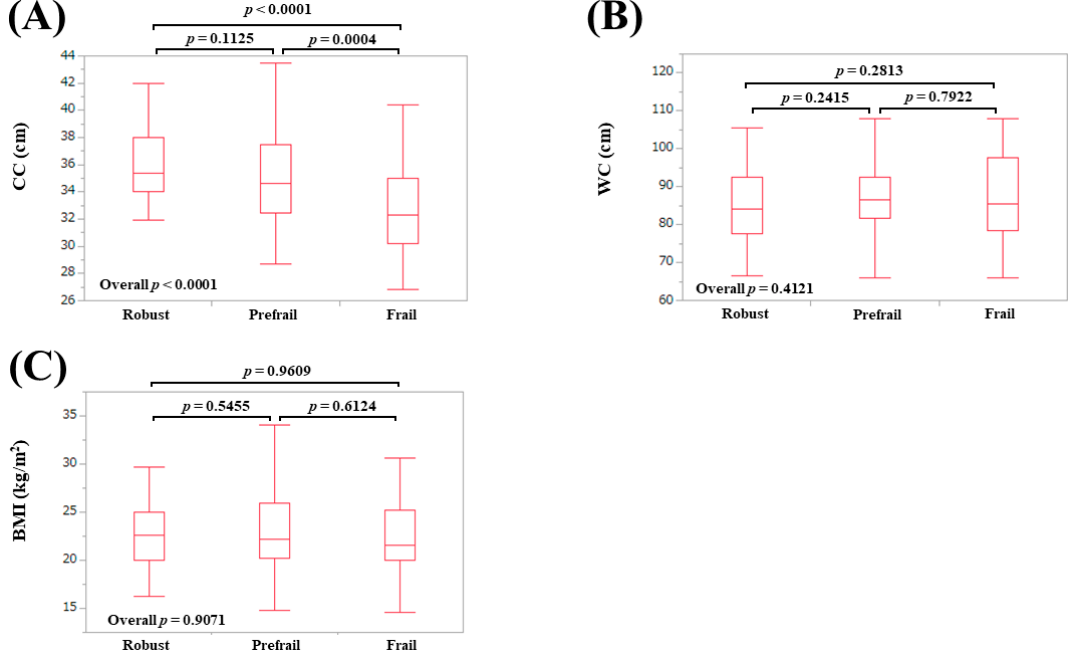
Figure 4. Anthropometry measurements according to frailty status in female participants. ( A ) Calf circumference; ( B ) Waist circumference; ( C ) Body mass index.